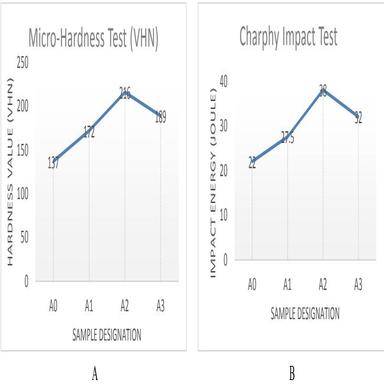
Variation of (A) micro-hardness (B) Charpy's Impact energy, of Al-4032 based MMCs